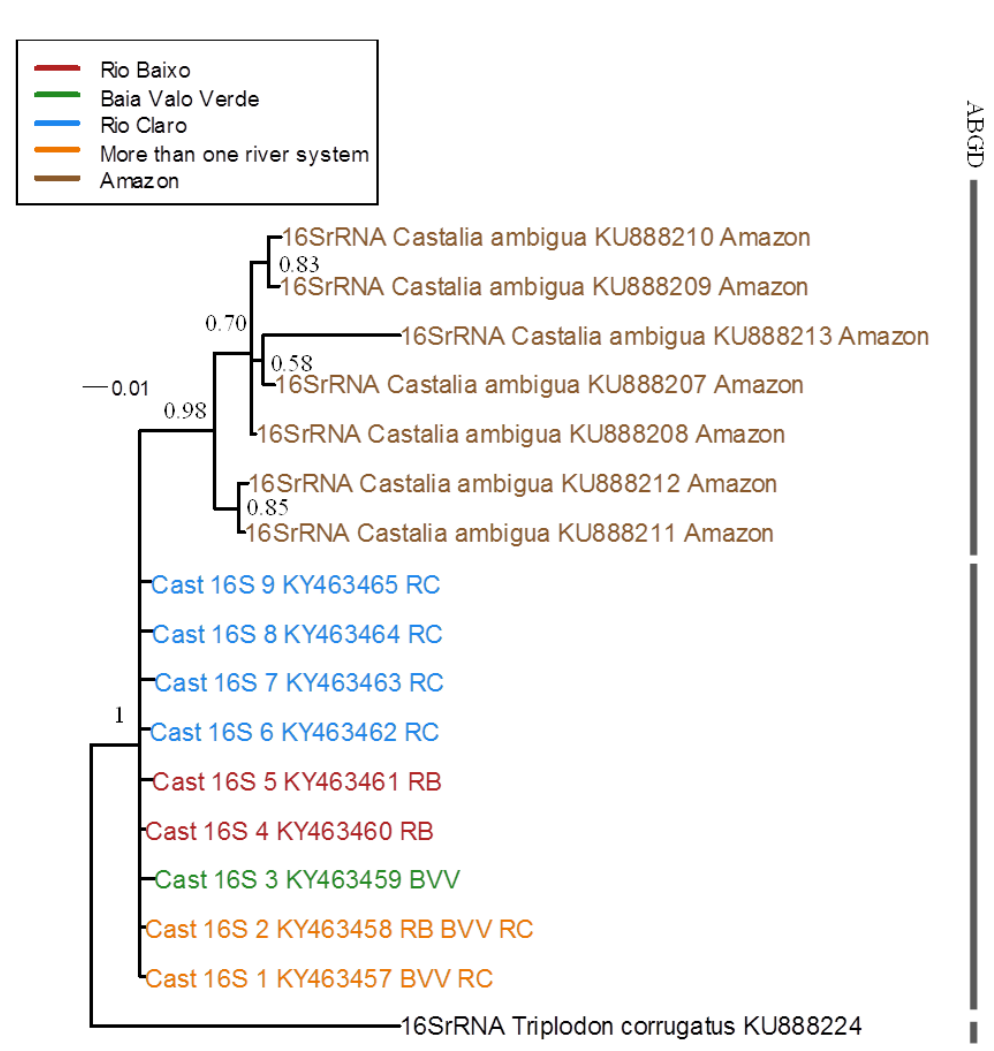
Figure 8. Bayesian phylogenetic analysis showing the relationships among the 16S rRNA haplotypes. In addition, seven individuals of C. ambigua (KU888207–KU888213) that were obtained from GenBank were included. The alignment of these sequences resulted in 308bp sequences. The analysis was run with a total of 500,000 generations, the final average standard deviation of split frequencies was 0.004356 with a − ln likelihood of − 822.58. a total of 7501 trees were sampled. Branch lengths are proportional to inferred evolutionary distances. Numerals to the left of nodes indicate posterior probability support for the respective nodes. Designators for each DNA sequence include the location (RC—Claro Stream, BVV—Vale Verde Lake, RB—Baixo Stream). The distance bar is shown in units of substitutions per nucleotide site. ABGD on the right margin refers to species delimitations suggested by Automatic Barcode Gap Discovery [57].